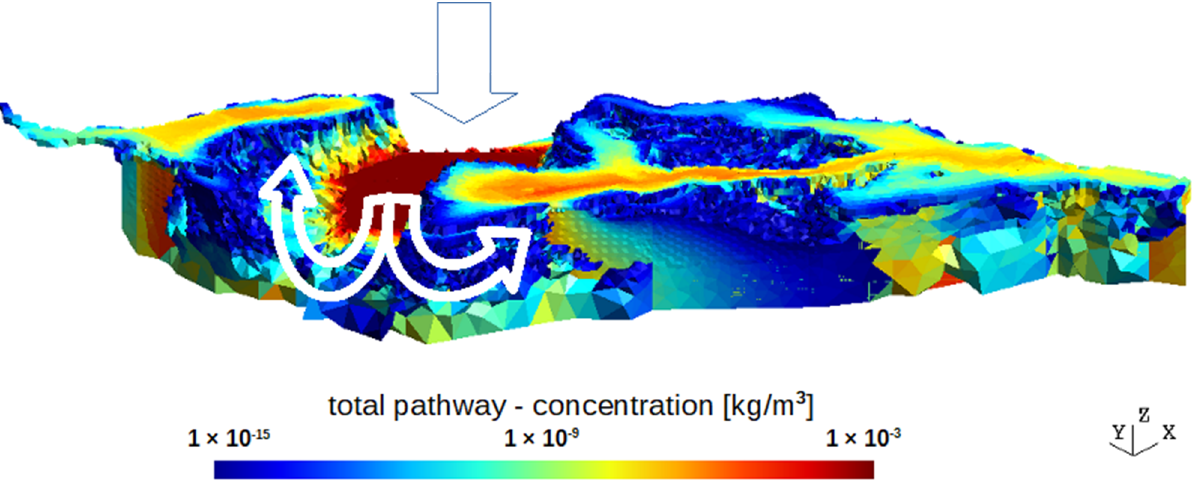
Figure 3. Concentration field of the continual tracer injection from the repository volume with a threshold value to detect the transport pathways. In this figure, the total transport path; that is, all the elements that are affected by the advection of the tracer from the source. The source itself has a dark red color; above it, the arrow indicates the main inflow of groundwater, and other arrows indicate the flow from the source elements further into the “geosphere”. This example shows the backflow in which the edge parts of the storage space are affected.